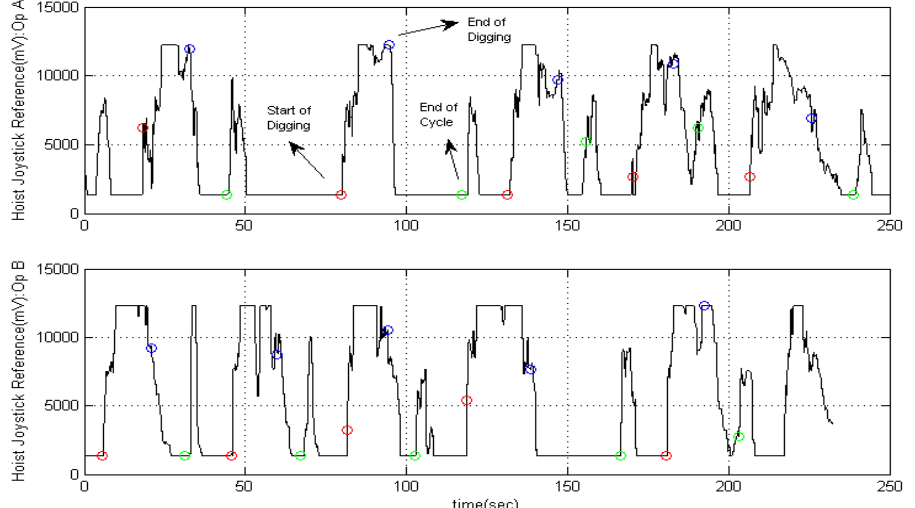
Figure 9. Hoist joystick reference.